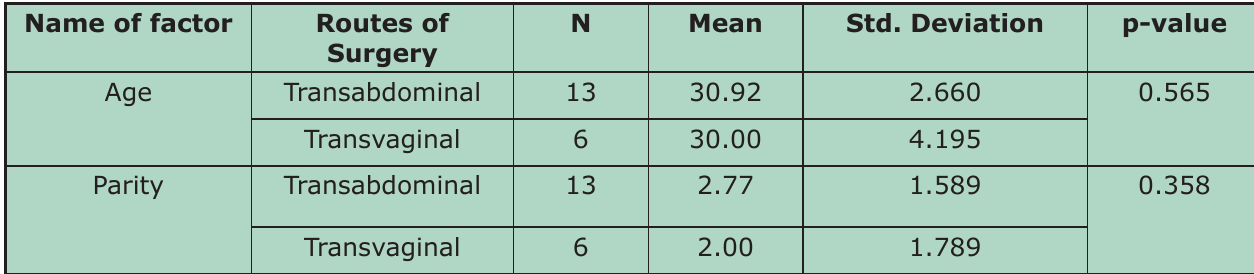
Table-II: Comparison between Transabdominal and Transvaginal routes of surgery on the base of age and parity using independent sample